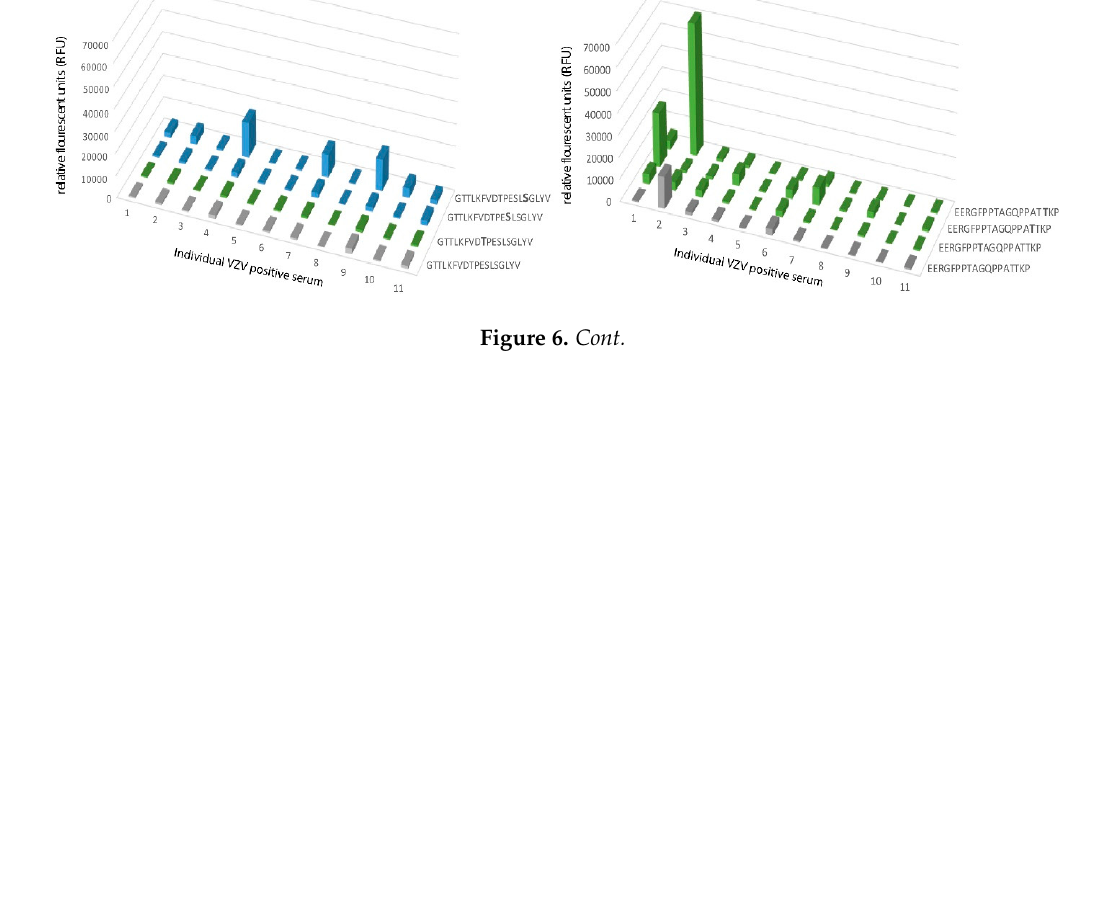
Figure 6. A heterogenous response towards synthetic peptides, with single or multiple GalNAc modifications, was observed for peptides covering parts of gE close to the transmembrane domain, including the MLD domain when individual serum samples were analyzed in detail. ( A ) Synthetic peptide 460-GTTLKFVDTPESLSGLYV-477 unmodified or modified by GalNAc residues at either Ser or Thr. ( B ) Synthetic peptide 505-EERGFPPTAGQPPATTKP-522 unmodified or modified by GalNAc residues at Thr. ( C ) Synthetic peptide 514-GQPPATTKPKEITPVNPG-531 unmodified or modified by GalNAc residues at Thr residues. ( D ) Synthetic peptide 523-KEITPVNPGTSPLLRY-540 unmodified or modified by GalNAc at either Ser or Thr residues. Grey: unglycosylated peptide. Blue: GalNAc modification on a Ser residue. Green: GalNAc modification on a Thr residue. X-axis shows the individual serum samples (n = 11) from VZV IgG-positive patients, plotted in the same order of individual sera in all graphs. 3. Discussion Although direct head-to-head comparative clinical studies of immune protection against HZ currently are lacking, the newly approved subunit vaccine Shingrix ® (HZ/su), based on gE of VZV, demonstrates efficacy data that seem to be superior to those of Zostavax ® , the currently used live attenuated vaccine [1,4,5]. At a first glance, this phenomenon may appear paradoxical, as live vaccines are considered to be optimal immunogens, as they mimic the original virus infection and activate all branches of the acquired immune response to target virtually all proteins encoded by the viral genome [32]. By contrast, a subunit vaccine is able to induce acquired immunity to only one or a few viral proteins contained in the vaccine, and it often depends on the quality of added adjuvants to compensate for the strong B and T cell responses induced by active viral replication. However, the